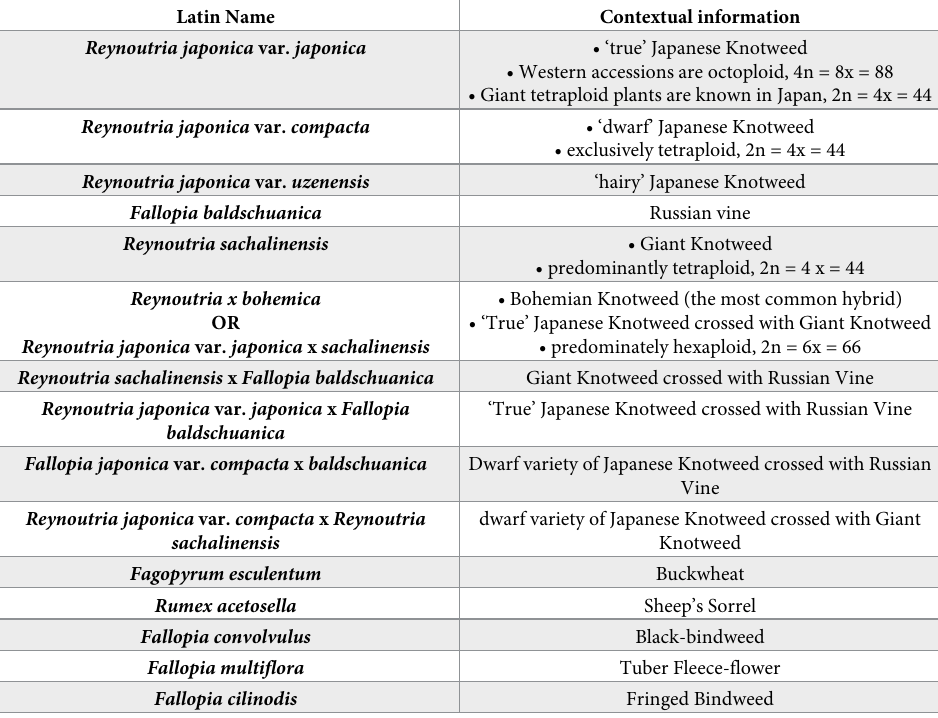
Table 1. Species information for samples within the Polygonaceae